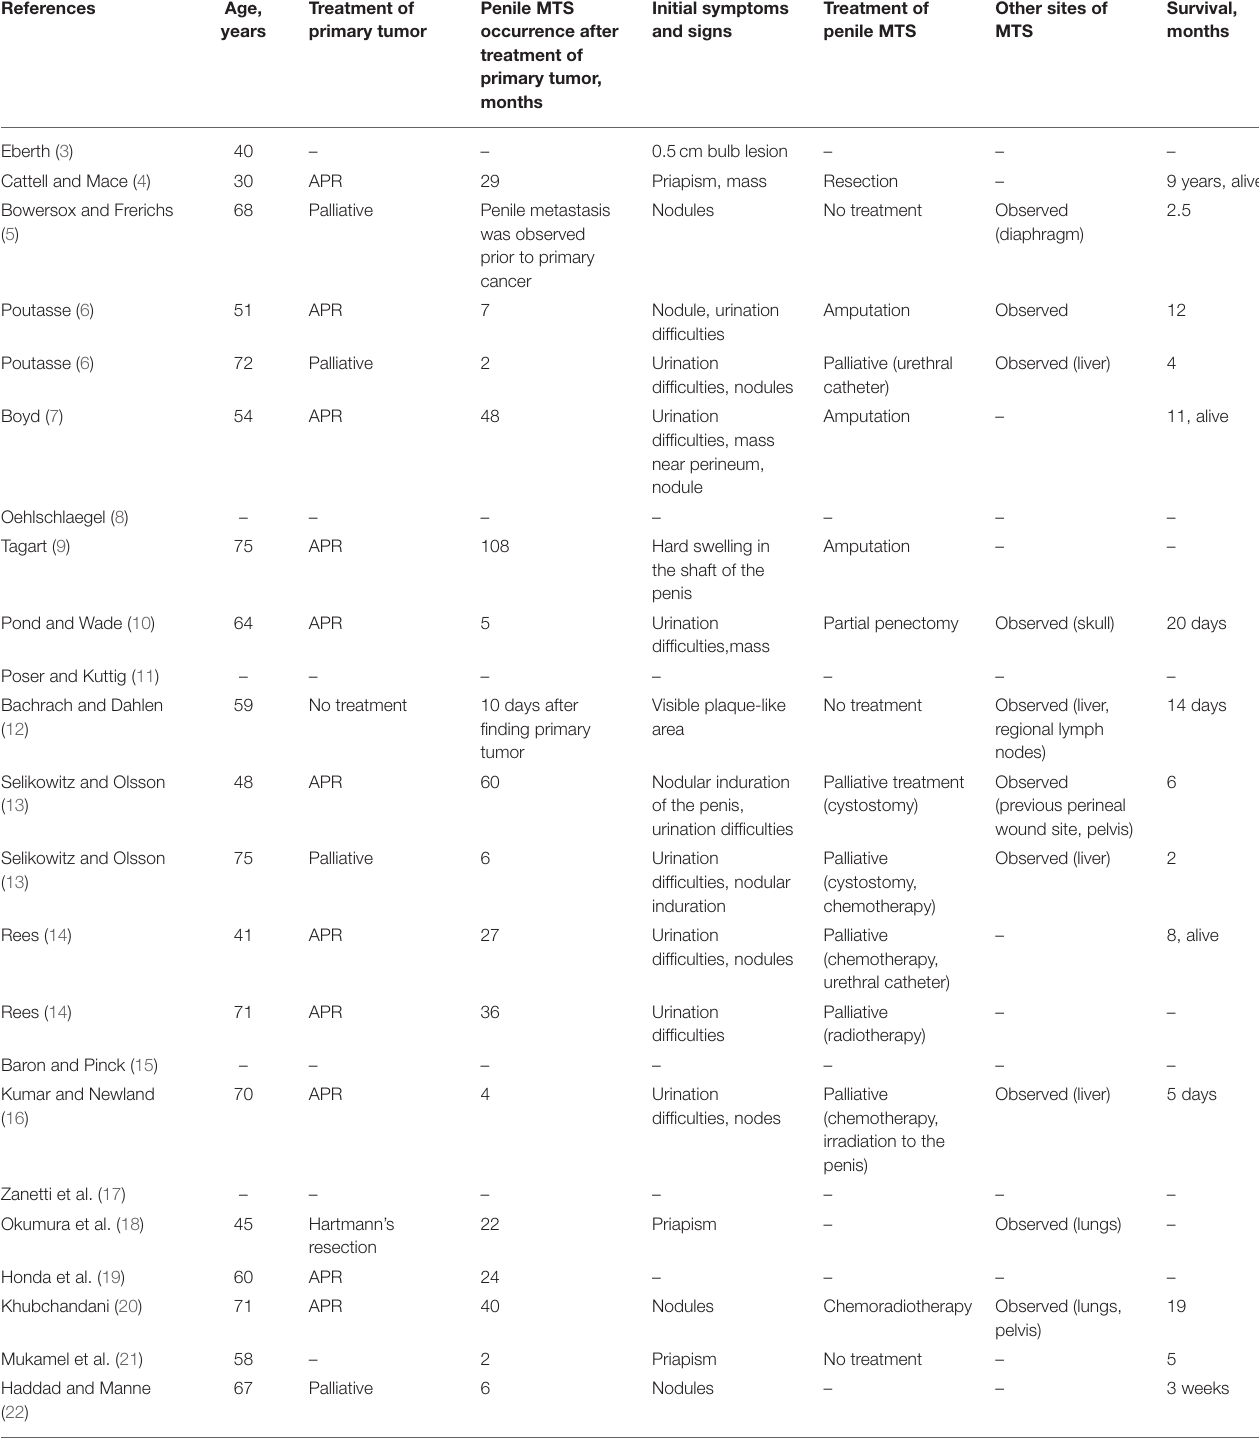
TABLE 1 | A literature review of previously published penile metastasis cases from rectal